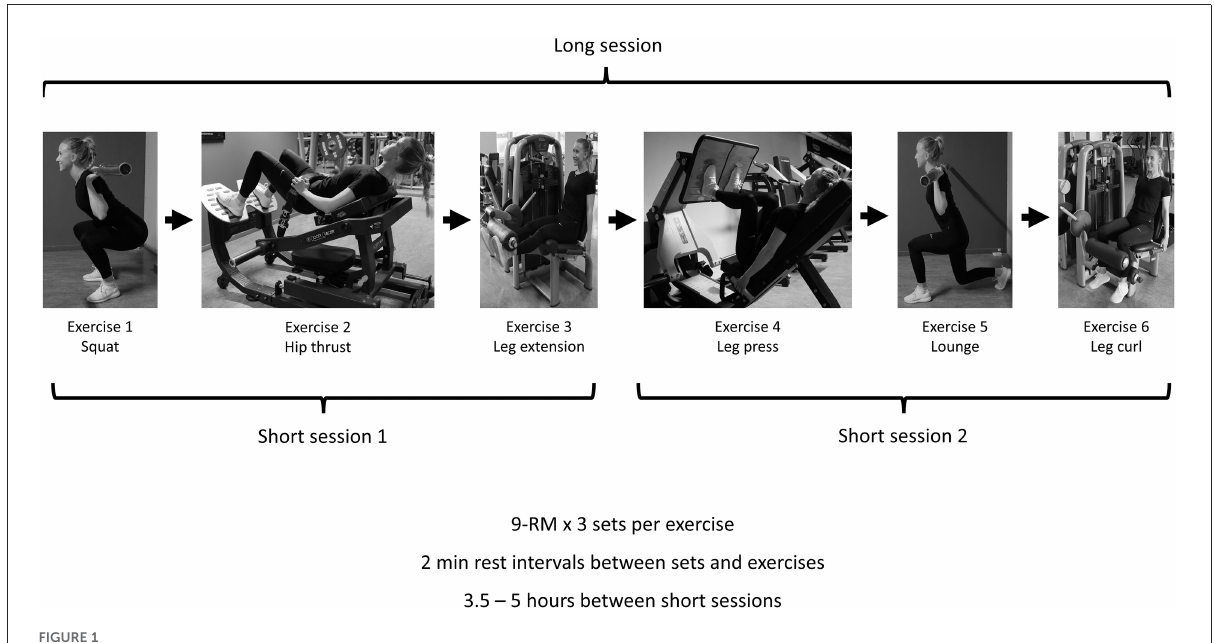
FIGURE1 An overview of the long and the two short sessions.